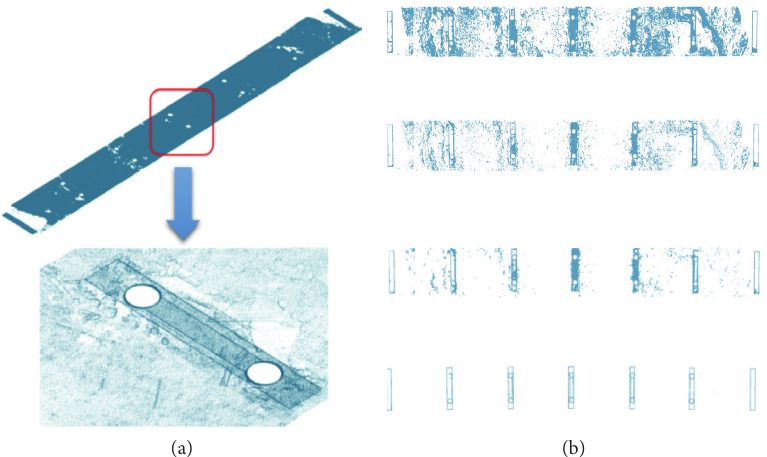
Figure 17: Projection filtering segmentation of the real bridge point cloud: (a) point cloud projection under the bridge; (b) ground point cloud removal.